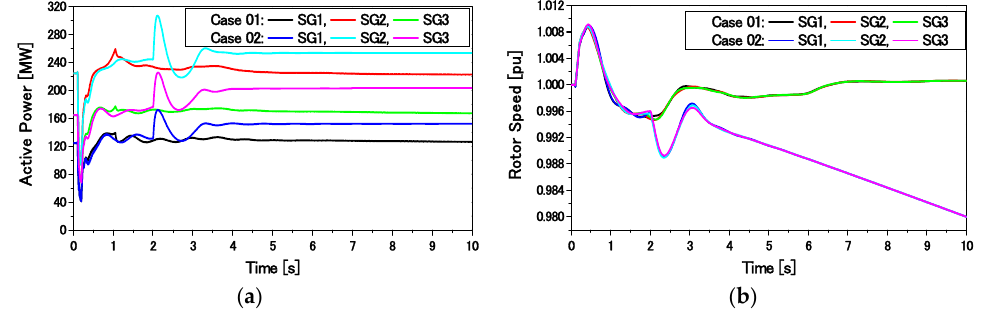
Figure 22. Individual responses of conventional SGs: ( a ) active power; ( b ) rotor speed.